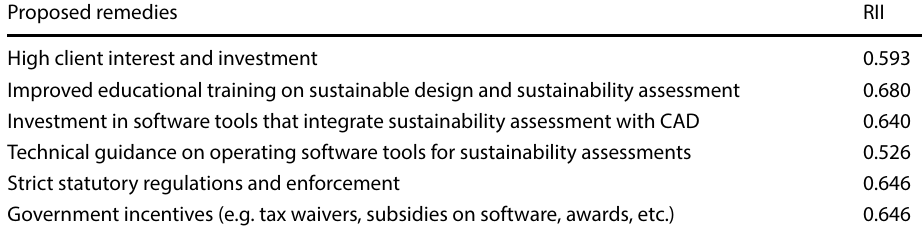
Table 5 Architects’ perspectives on remedies to SBD